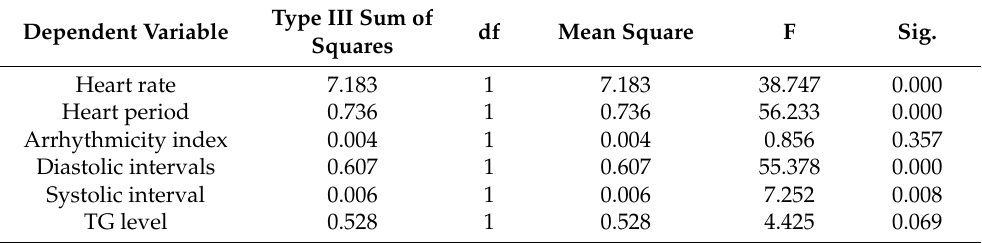
Table 1. Two-way analysis of variance results for interaction effect of 12D Drosophila physical skd × HFD. Dependent